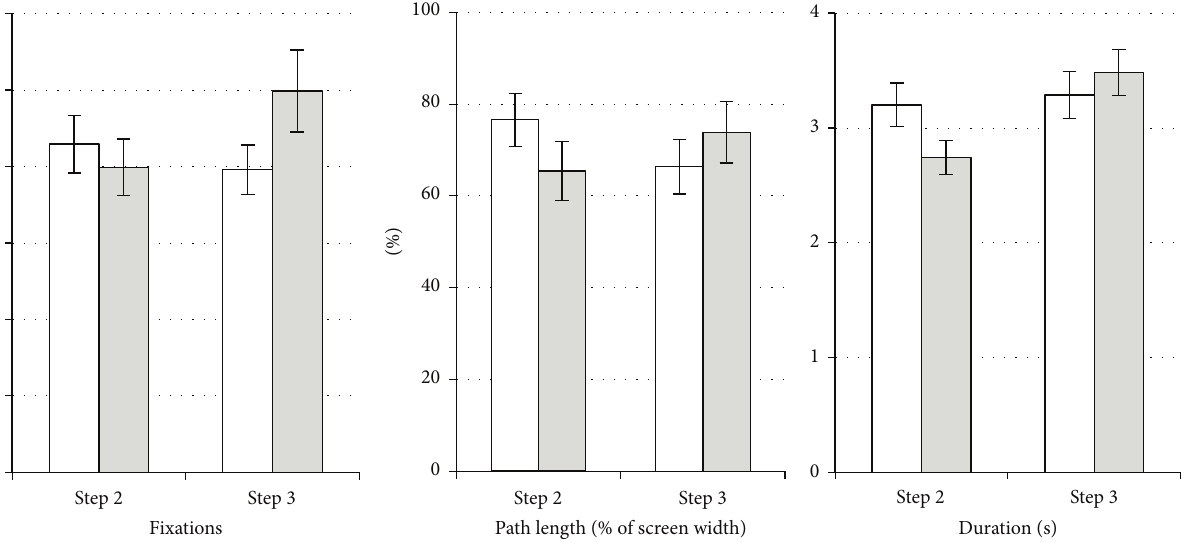
Figure 2: In experiment 1 , the translated design (grey bars) produced better performance for step 2, but the collocated design (white bars) was better for step 3. Overall, the designs were equivalent. Errors bars show one standard